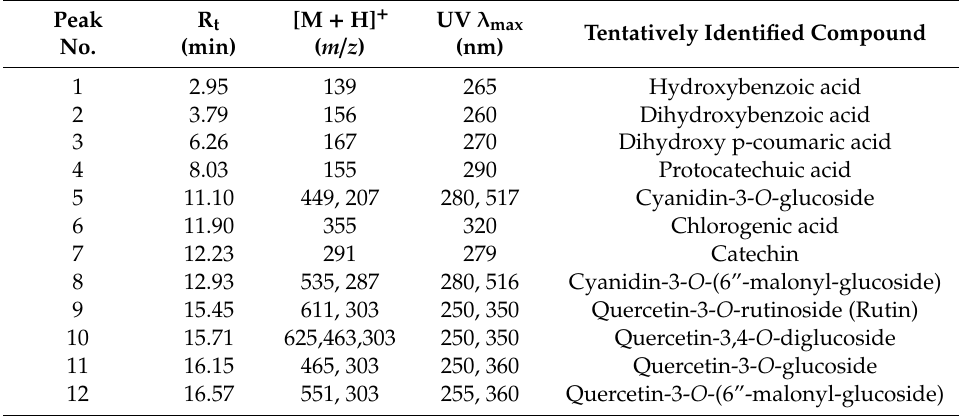
Table 3. Characterization of phenolic compounds in red chicory via positive mass spectrometry LC- Mass Spectrometry (MS).